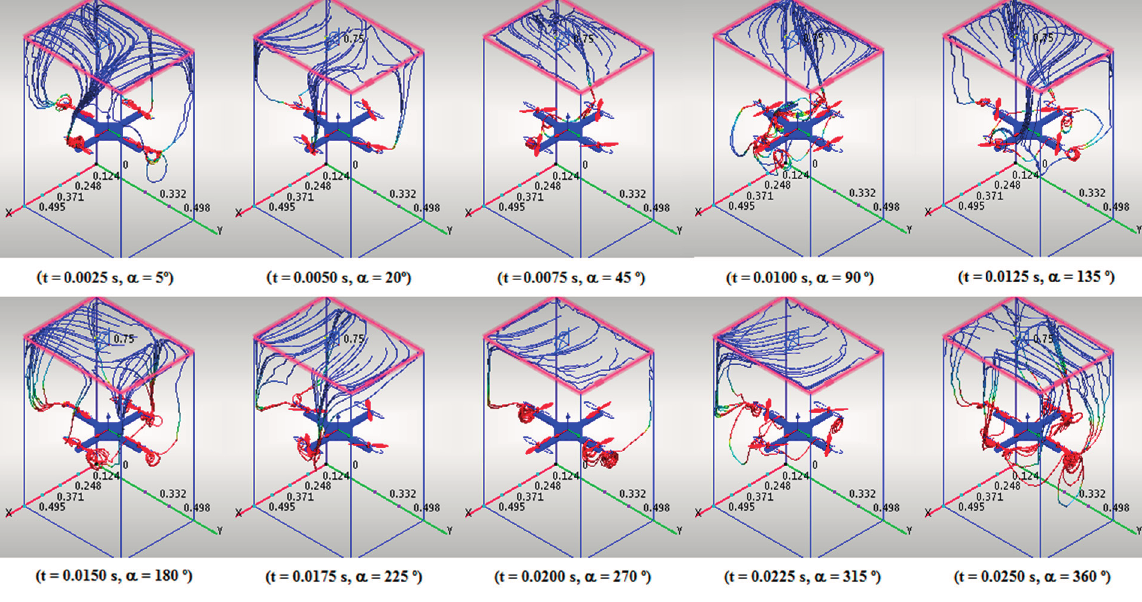
Figure 3. Airflows over the